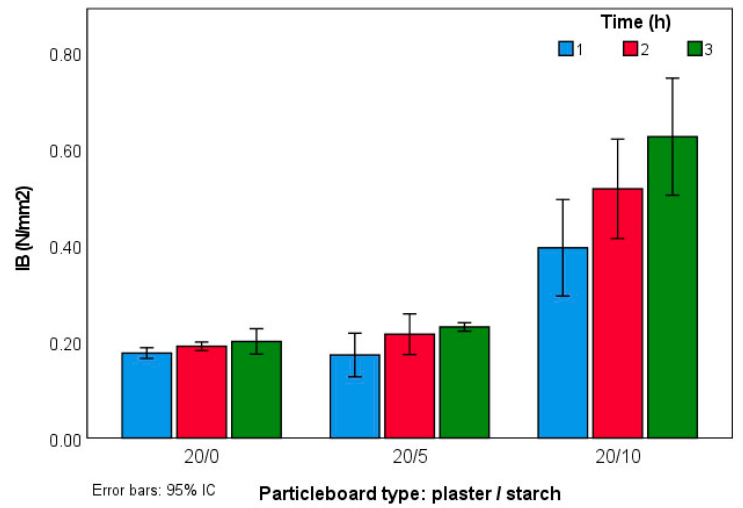
Figure 7. IB values of the experimental panels.